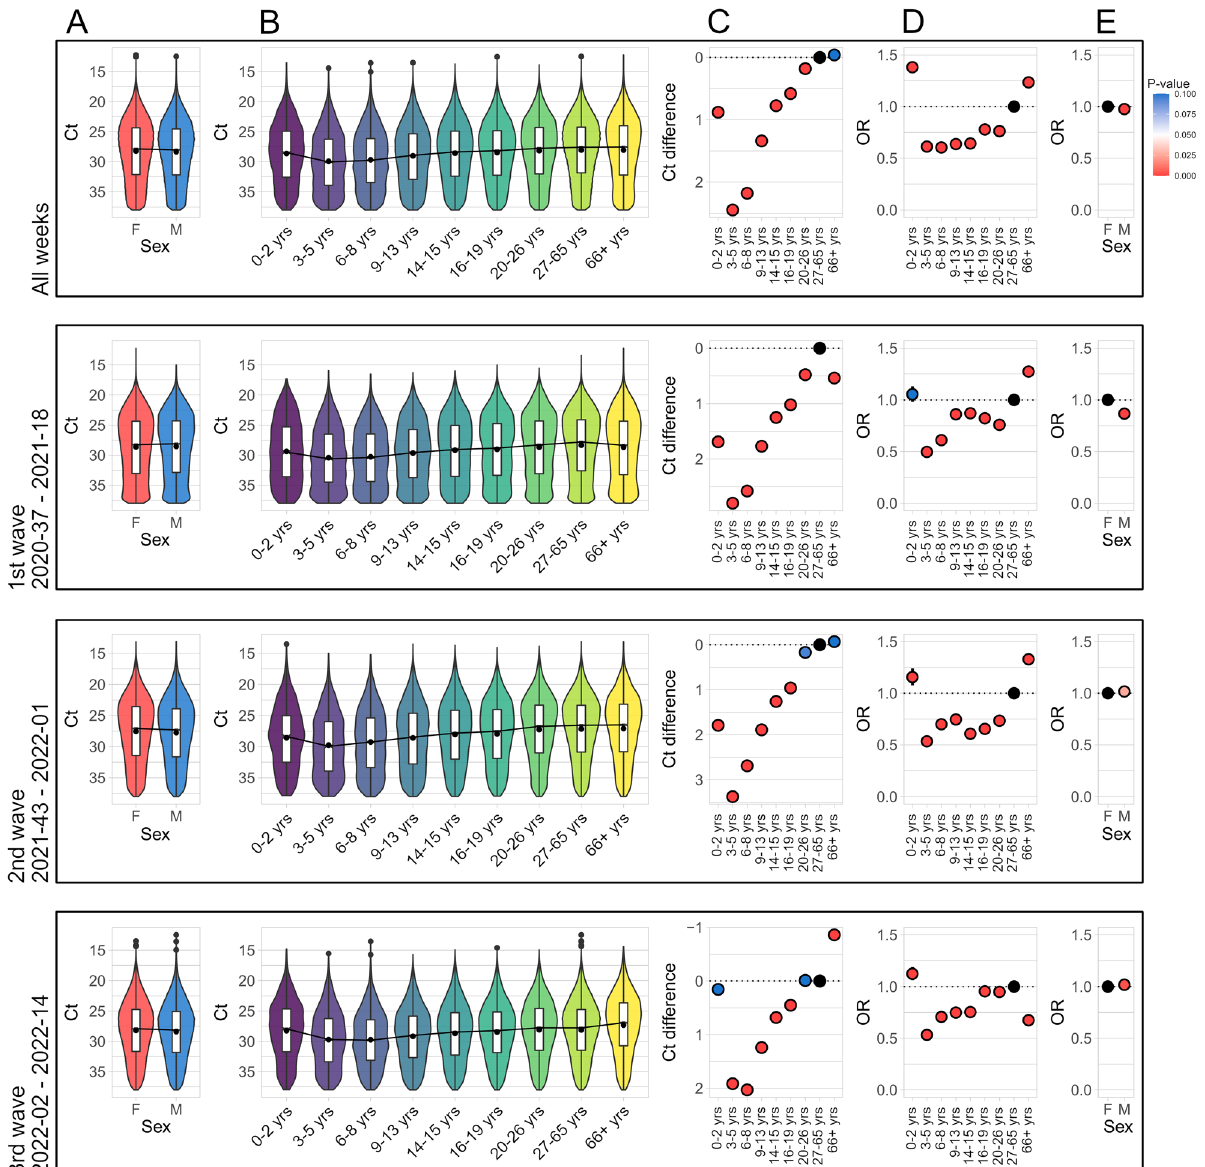
Figure 3. Ct distributions of positive tests categorized according to the sex ( A ) or age of the individual ( B ). Data are shown as violin plots, supplemented with Ct means (black points) and notched boxplots. Medians are connected with a black line. ( C ) Differences of median Ct values (compared to the group of adults 27–65 years). Color of the points corresponds to P-values from Dunn´s test. ( D ) Odds ratios of test positivity rate per age group compared to the group of adults (27–65 years). ( E ) Odds ratios of test positivity rate according to the sex. Confidence intervals were computed using the median-unbiased estimation (mid-p method), color of the points corresponds to P-values from Fisher´s exact